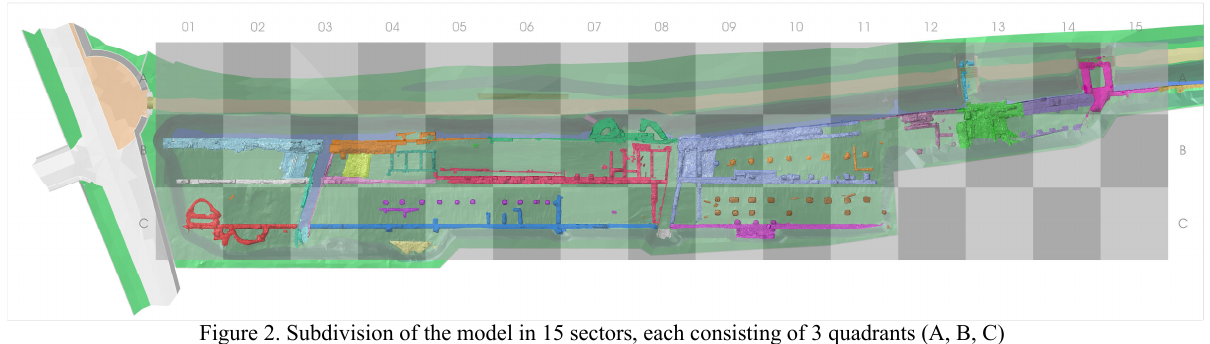
Figure 2. Subdivision of the model in 15 sectors, each consisting of 3 quadrants (A, B, C)